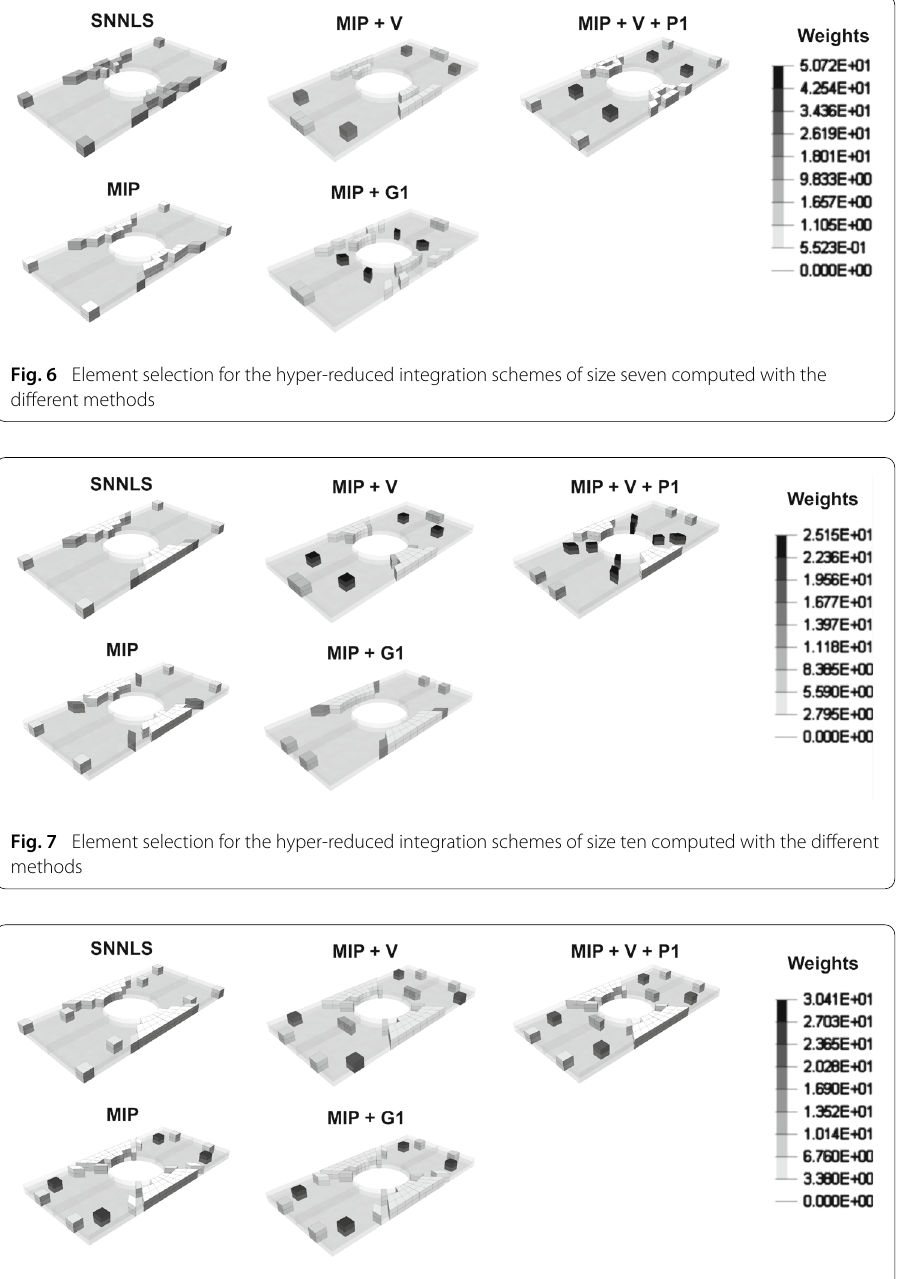
Fig. 8 Element selection for the hyper-reduced integration schemes of size fourteen computed with the different